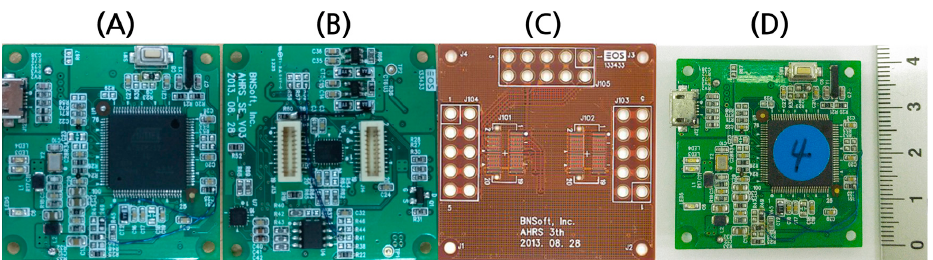
Figure 2. ( A ) Front and ( B ) back views of the custom-made IMU sensor module and ( C ) flexible printed circuit board (FPCB) for interconnection. ( D ) Combined sensor modules attached on the